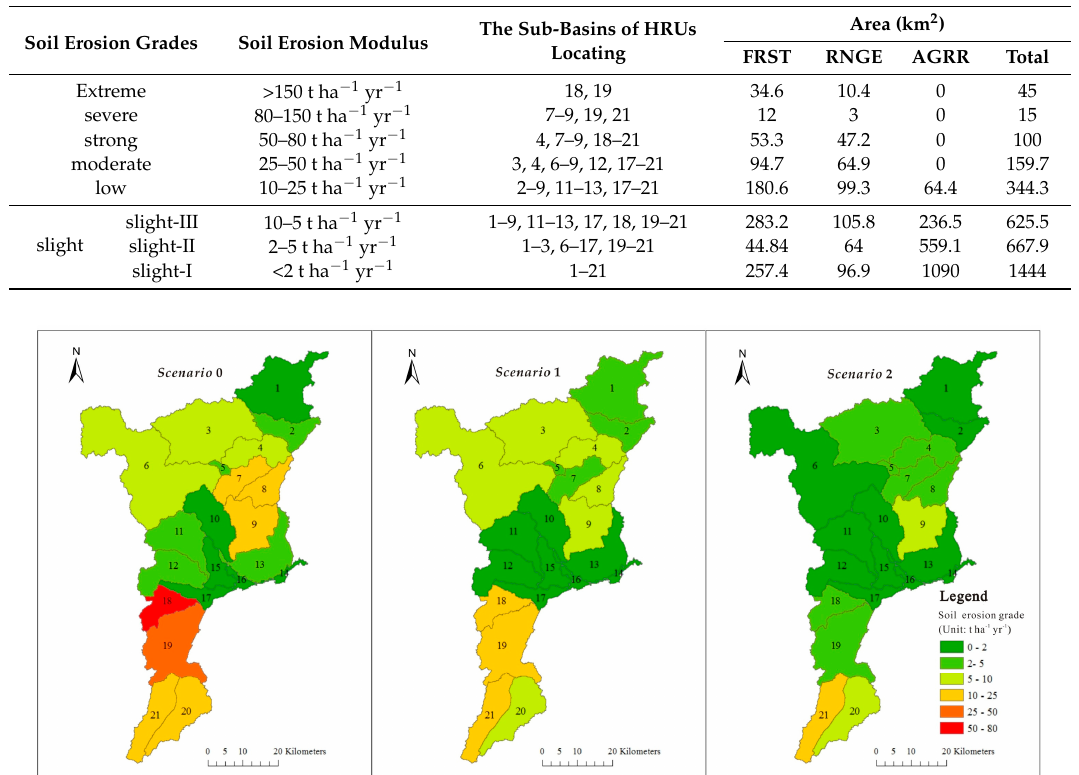
Figure 7. The spatial soil erosion variability in the sub-basins simulated by the SWAT model in the USK river basin under Scenario 0, Scenario 1, and Scenario 2. Table 5. The soil erosion gradation of different land use in sub-basins of the USK river basin from 1986 to 2012.